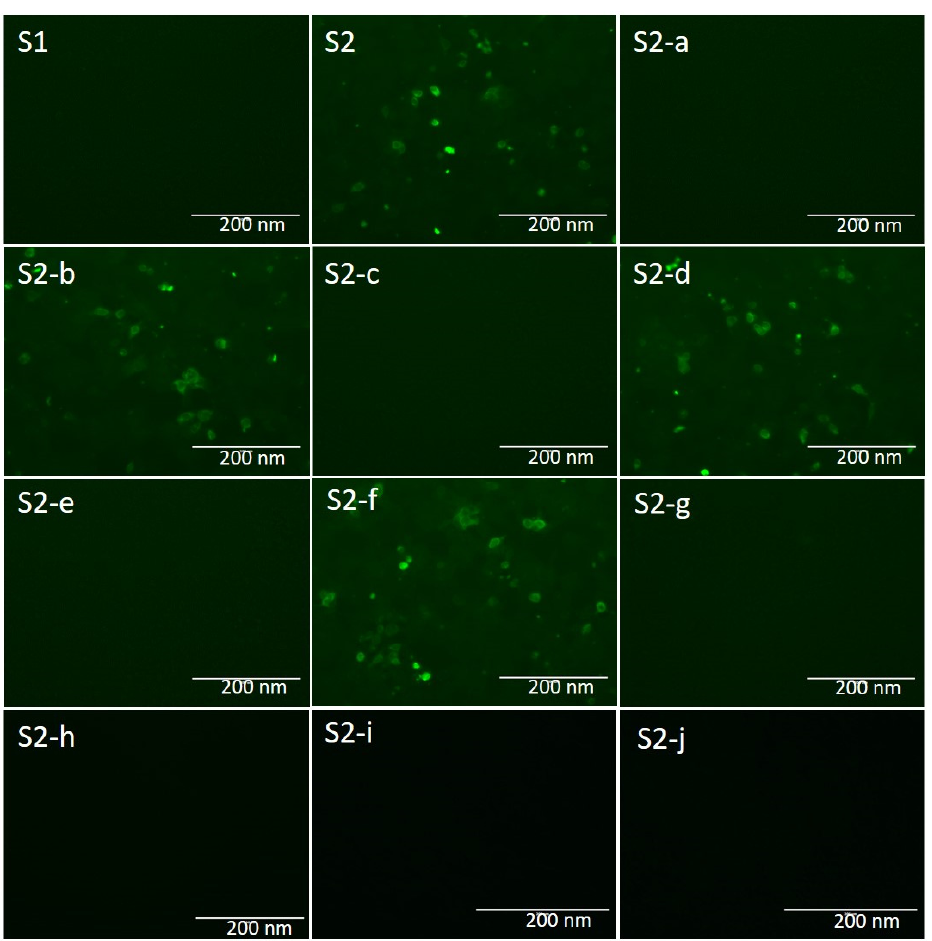
Figure 5. Identification of the epitope recognized by mAb 5F7 using IFA. Recombinant plasmids pcDNA3.1( − )–LNCT2–S1 and –S2, as well as pcDNA3.1( − )–LNCT2–S2-a, -b, -c, -d, -e, -f, and -g, were used to transfect 293T cells. The results show that the cells transfected with pcDNA3.1( − )–LNCT2-S2, S2-b, -d, and f plasmids reacted with mAb 5F7, while the cells transfected with pcDNA3.1( − )–LNCT2-S1, S2-a, -c, -e, -g, -h, -i, and -j plasmids did not react with mAb 5F7. Bar, 200 µ m.